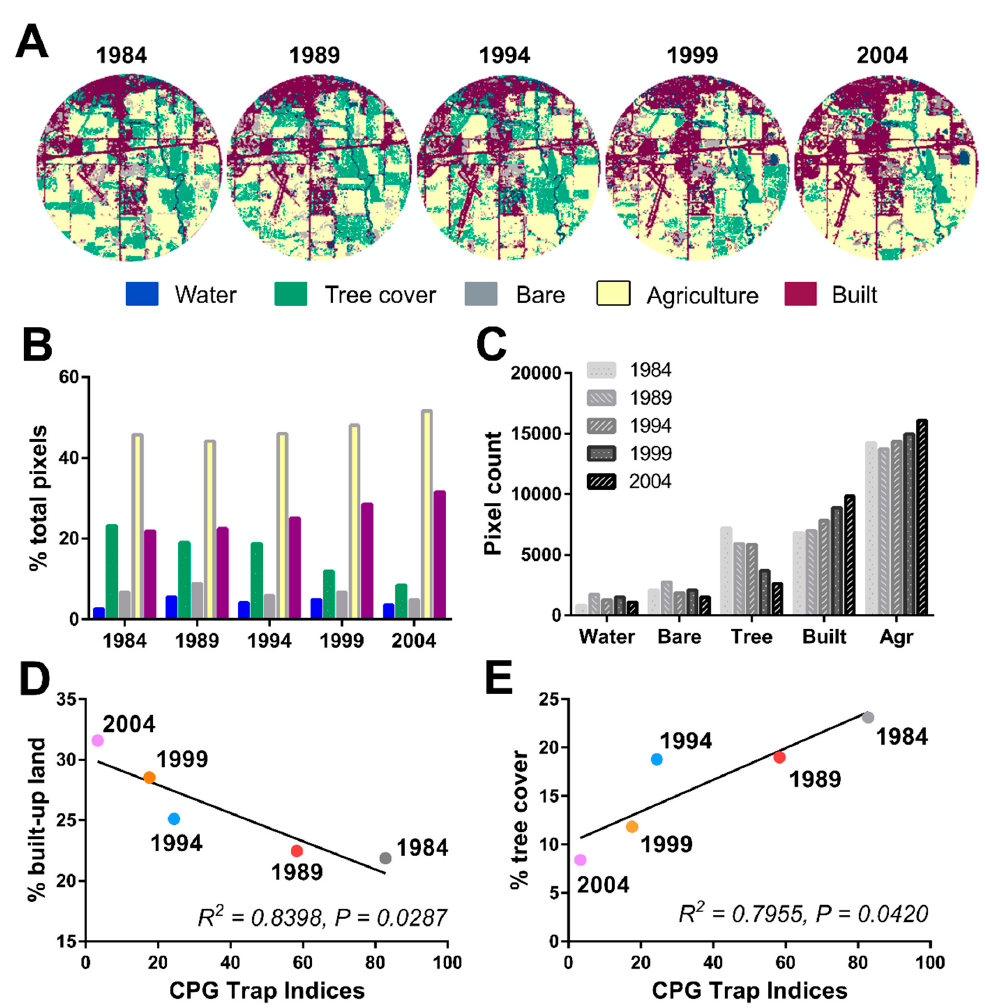
Figure 4. Changes in land use and land cover near the Ames site from 1984–2004. A supervised classification time series of land use/land cover every five years from 1984 to 2004 shows increases in built-up land over time (maroon) and a decrease in tree-covered land (green) in a 4 km fixed area around the Ames trap site ( A ). Changes in land use/land cover classification are displayed by each year according to classification ( B ) or by classification over time ( C ). Values are displayed as percentages of total pixels or total pixel count respectively. Relationships of CPG abundance (averaged over a five-year period ending in the year displayed) were examined by simple linear regression with the percentage of built-up land ( D ) or percent tree cover ( E ). Land use percentages for the 5-year intervals were derived from land use/land cover classifications above. To connect changes in landscape near the Ames trap site to the decline in CPG populations, a simple linear regression was run using the land classification percentages for built-up land and tree cover (Figure 4). Annual CPG populations were similarly grouped into five-year increments to match the five-year increments used for land use measurements. These results show a negative relationship between the percentage of built-up land with CPG trap index values (R 2 = 0.8398, p = 0.0287, F = 15.72, df: 1, 3; Figure 4D) and a positive relationship between percent tree cover and CPG trap index values (R 2 = 0.7955, p = 0.0420, F =11.67, df: 1, 3; Figure 4E). Similar analysis examining correlations of CPG populations with water, bare, or agricultural changes had no effect (Figure S4). Together, this suggests that specific changes in land use near the Ames site significantly impacted CPG populations.